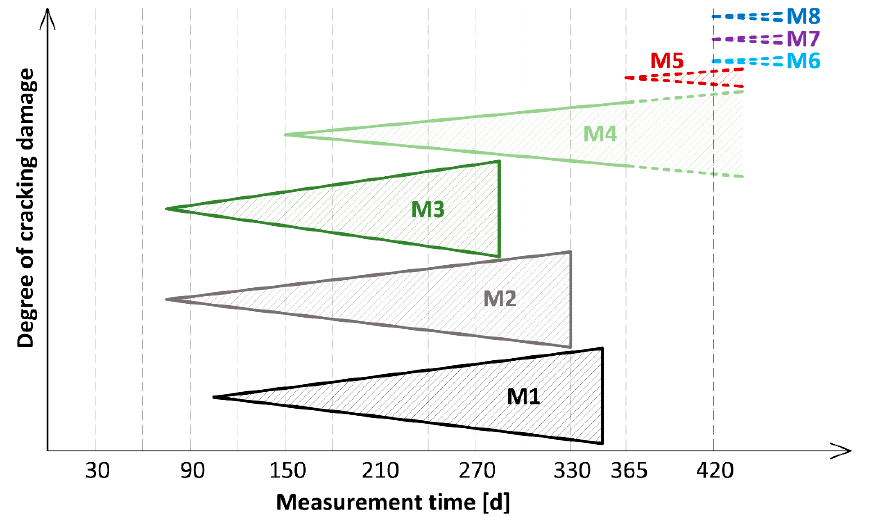
Figure 14. Cracking of MMs during the sulfate test, expressed with TBTC.